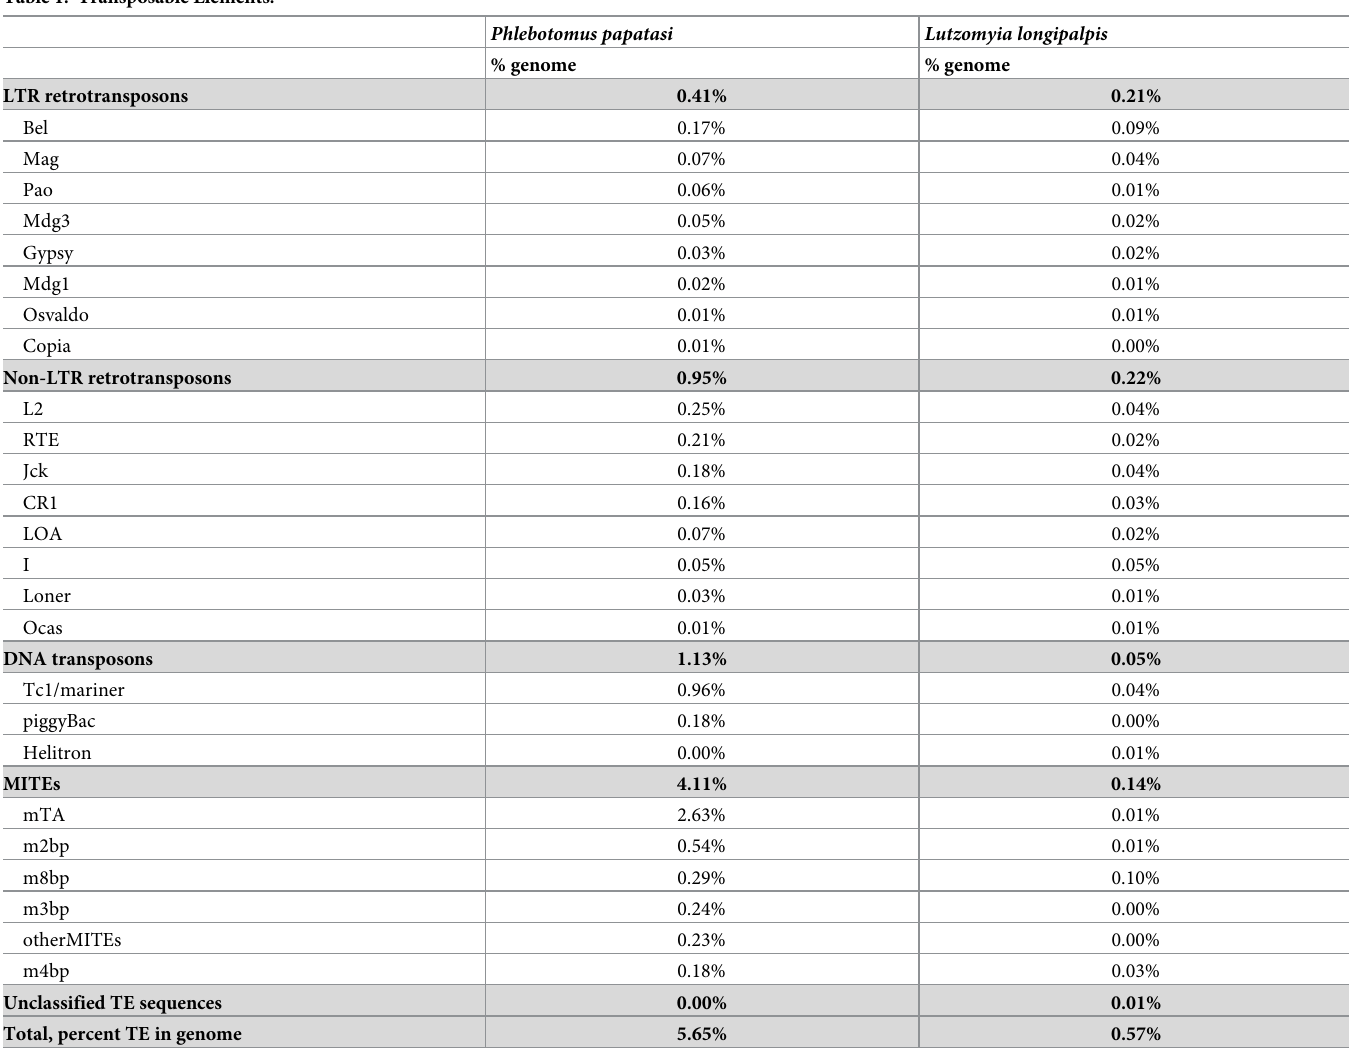
Table 1. Transposable